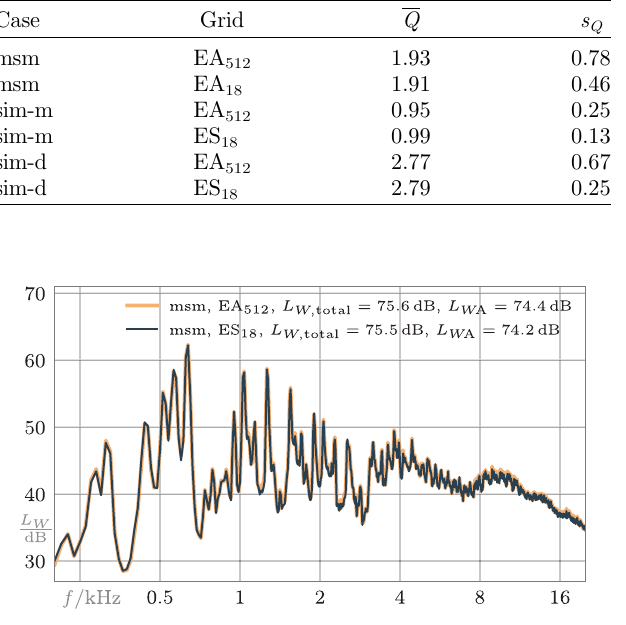
Figure 19. Narrow-band sound power spectrum ( D f = 12.5 Hz) of the measured drone.